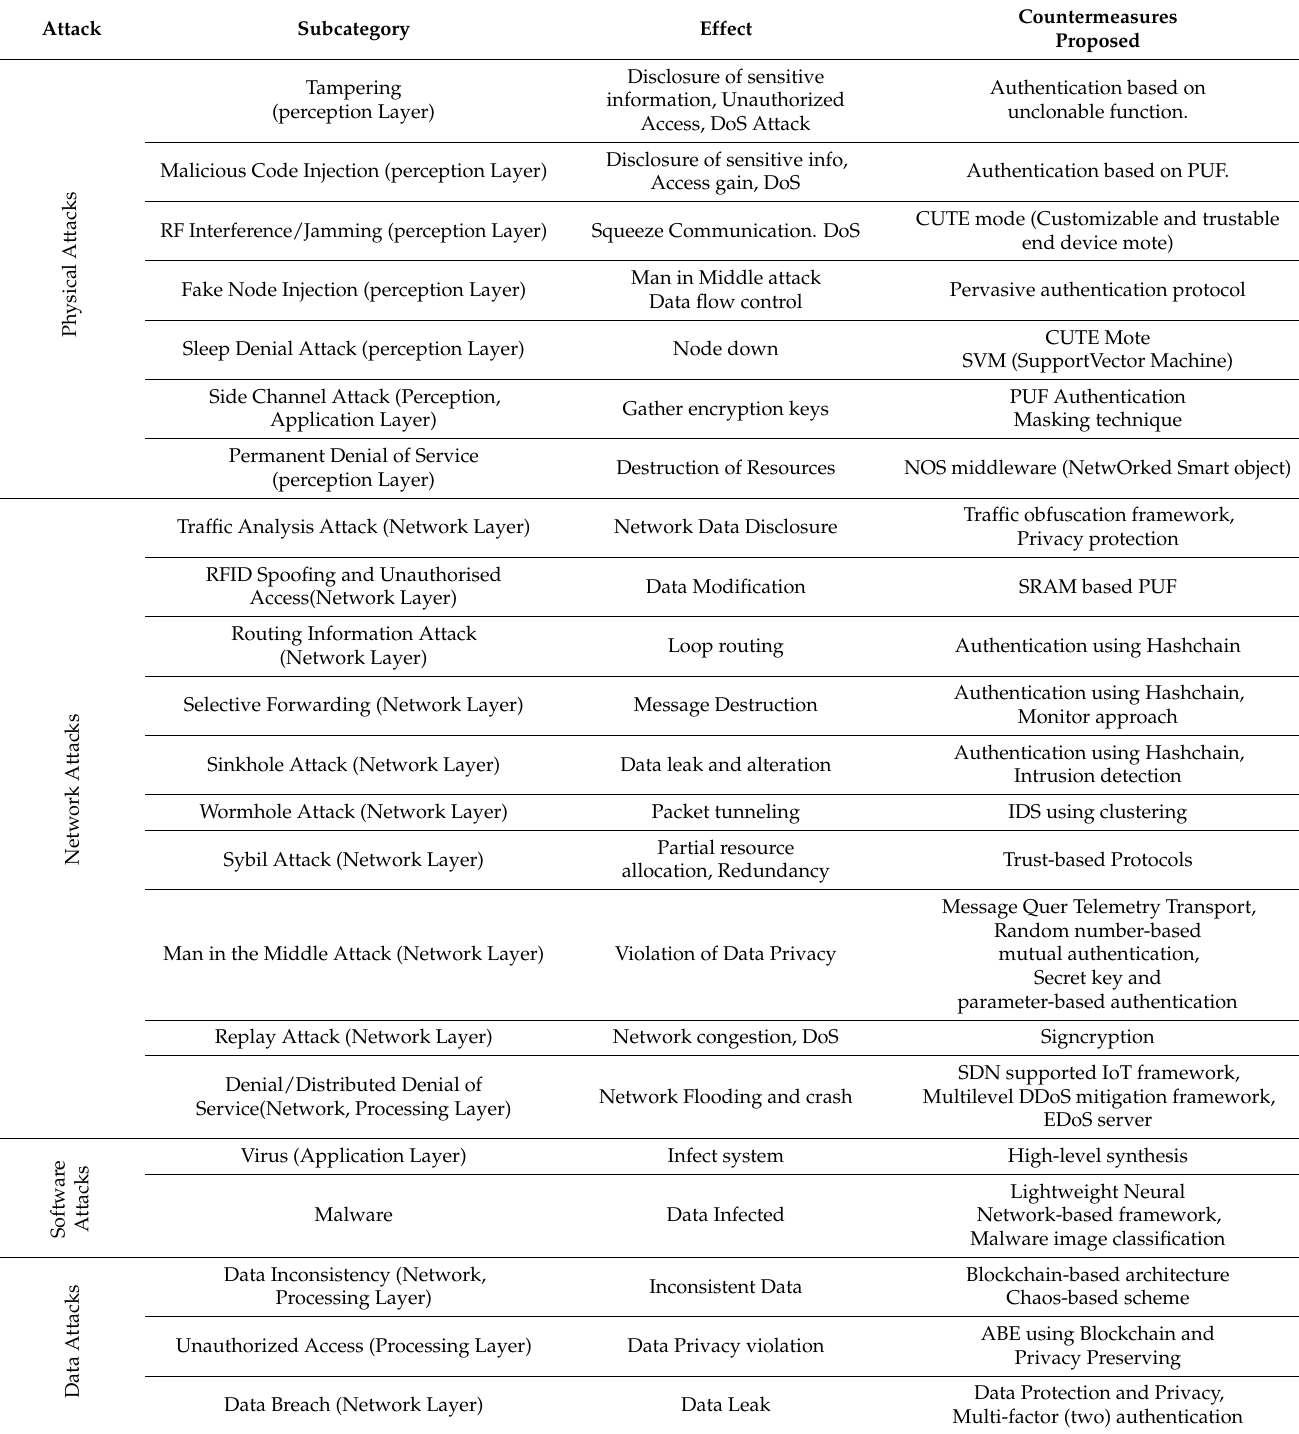
Table 1. Categorization and brief overview of possible attacks on IoT and IIoT systems with security